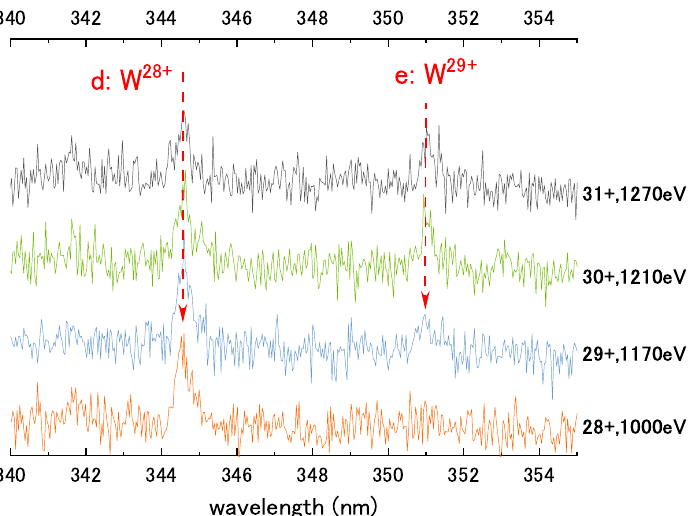
Figure 3. Emission lines of W 28 + and W 29 + ions in CoBIT-II. This is a magnification of the wavelength range and the vertical scale of Figure 2 for 1000–1270